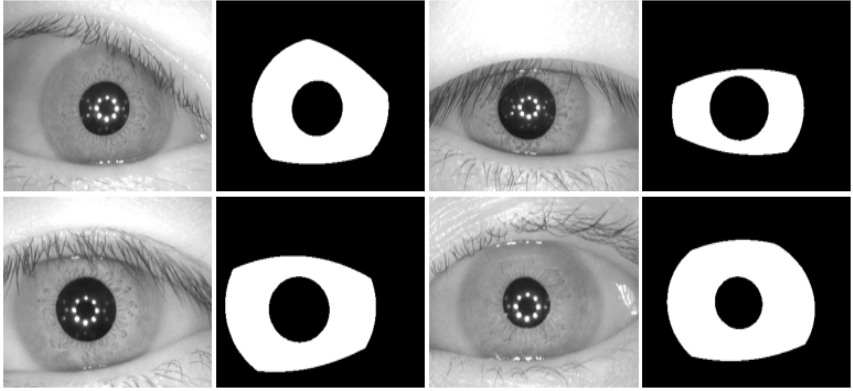
Figure 11. The institute of automation, Chinese academy of sciences (CASIA) v4.0 interval sample images with corresponding ground truths.